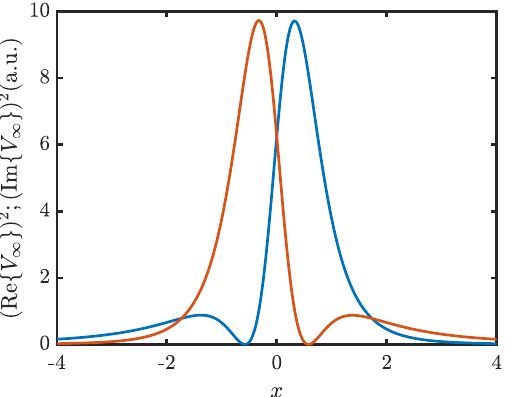
Figure 5. Squared real (blue) and imaginary (red) parts of V ∞ ( x ) for large | ε | , in arbitrary